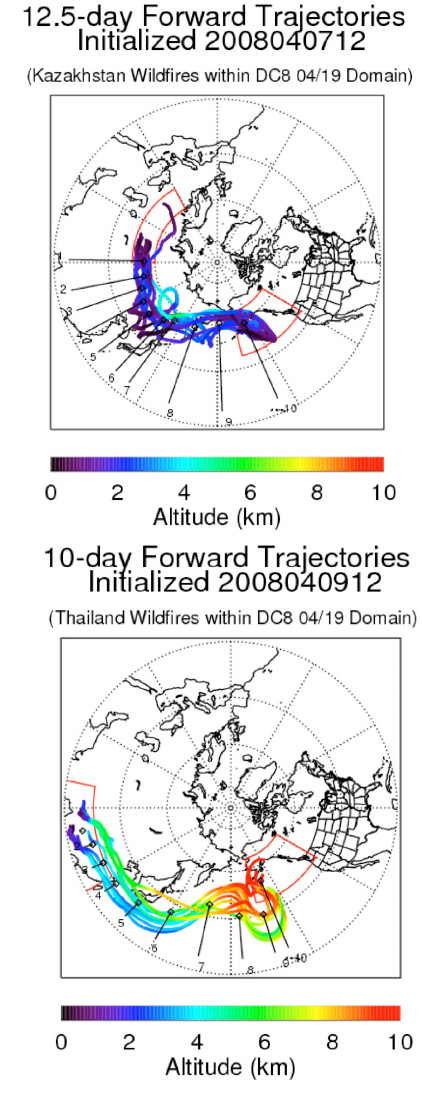
Figure 3a: (upper) RAQMS Trajectories from Kazakhstan Plume and 3b (lower) Siberian Plume Fig. 3. (a) RAQMS Trajectories from Kazakhstan Plume and (b) Siberian